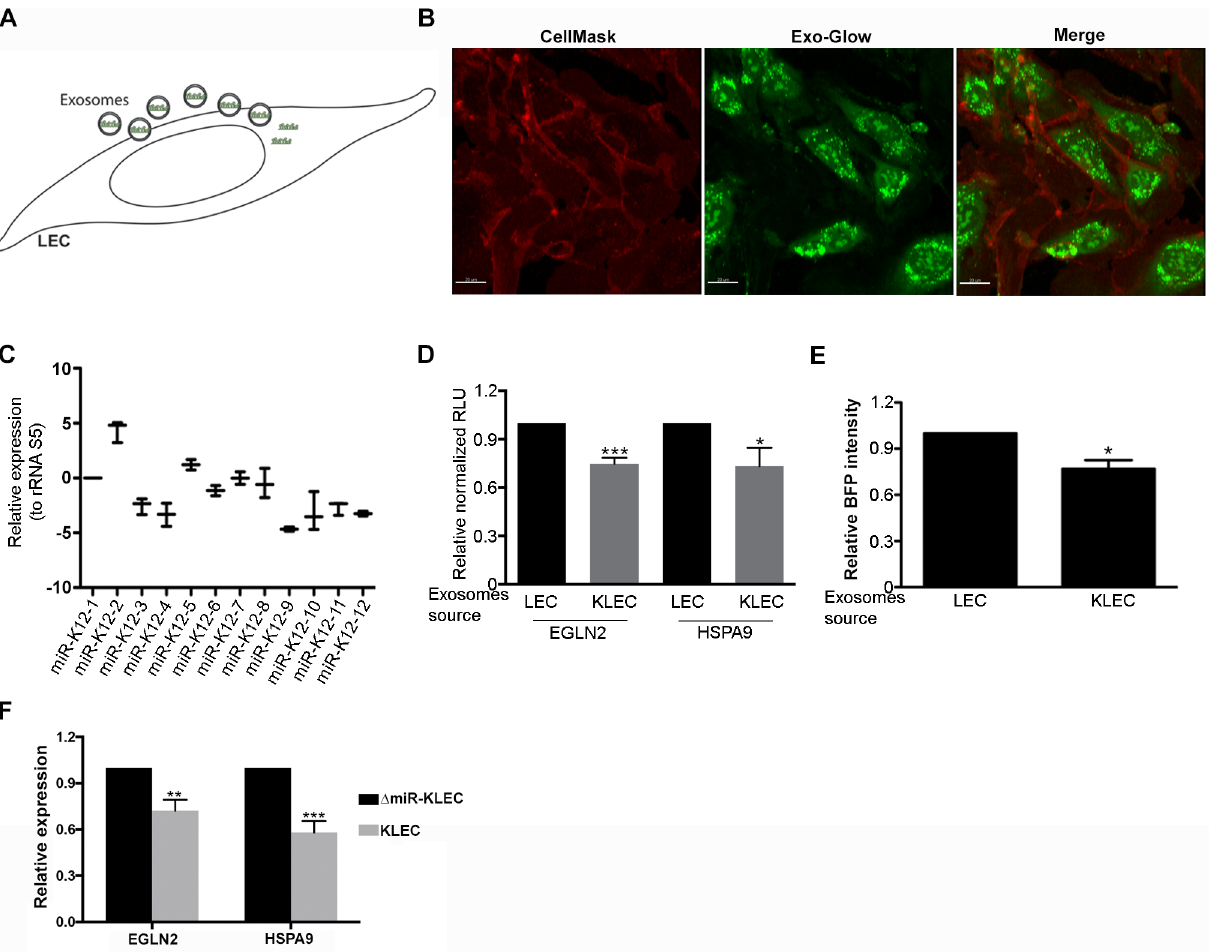
Fig 2. KSHV miRNAs are transferredvia exosomes to naive cells to regulate gene expression. (A) Schematic illustration of exosomes education—10 5 non-infected cells were incubatedfor total of 48 hours when 2.5x10 9 exosomeswere added every 24 hours. (B) KLEC exosomesare being taken up by naive LEC. LEC were first stainedusing CellMask deep red, then incubatedwith GFP labelledexosomes and analysedusing a confocalmicroscope. (C) LEC were educatedusing 2.5x10 9 KLEC-derived exosomesand tested for the presence of the mature KSHV miRNAs using the KSHV-miR LNA PCR primer sets (Exiqon) relative to the ribosomal RNA S5. (D) Reporter assay indicating the sensitivity of the EGLN2 or HSPA9 3’UTRs to targeting by the KSHV miRNAs. Cells expressingthe reporter vectors were educatedusing LEC or KLEC-derived exosomesand analysedfor luciferase activity. Firefly expressionof each sample was internallynormalized to Renilla expressionto give the relative light units (RLU), which are presented relative to cells educatedusing LEC exosomes. (E) Reporterassay indicating miR-K12-10is active in recipient cells. Cells expressinga blue fluorescent protein (BFP) fused to 8 repeats of the miR-K12-10 targeting sequencewere educatedusing LEC or KLEC-derived exosomesand analysedfor BFP expressionby fluorescence-activatedcell sorter (FACS). (F) RelativemRNA levels of EGLN2 and HSPA9 in LEC educatedusing KLEC-derivedexosomes comparedto LEC educated using Δ miR-KLEC-derived exosomes. mRNA levels were determined by qRT-PCR. TUBB levels were used for normalisation.All panels present the mean and standarddeviationof 3 biologicalrepeats. Statistical significancewas denotedby * P < .05, ** P < .01, *** P < .001.